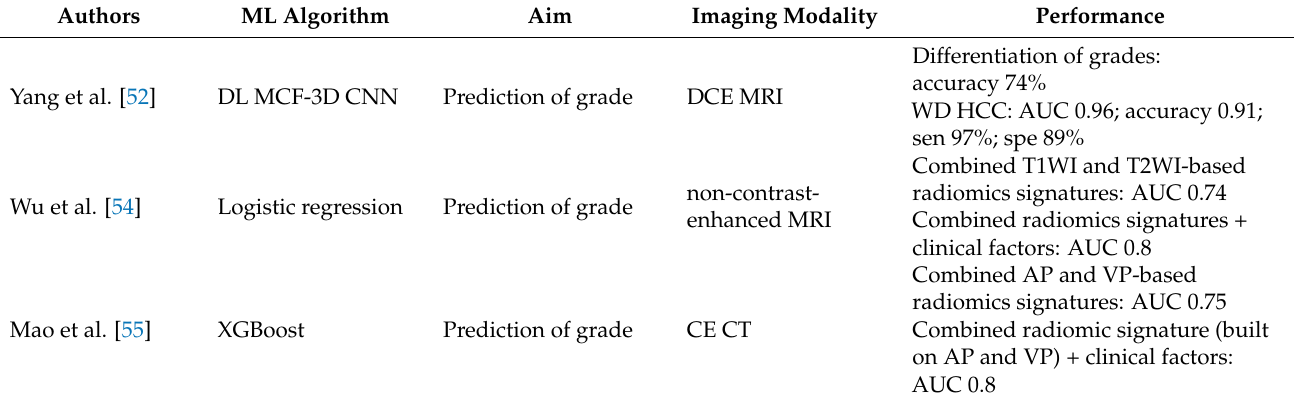
Table 3. Overview of ML algorithms applied to hepatocellular carcinoma grade